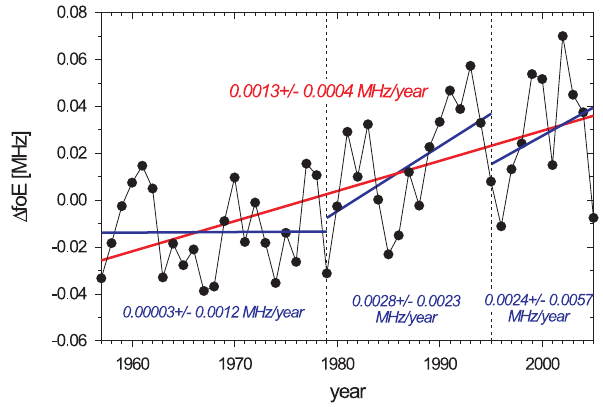
Fig. 12. Long-term variation of foE deduced from observations at 45 stations in mid-latitudes (30–60 ◦ N, 30–60 ◦ S) after elimination of the solar and geomagnetic influences. The red line is the linear trend for the whole interval between 1957 and 2005, the blue lines characterize the trends in different